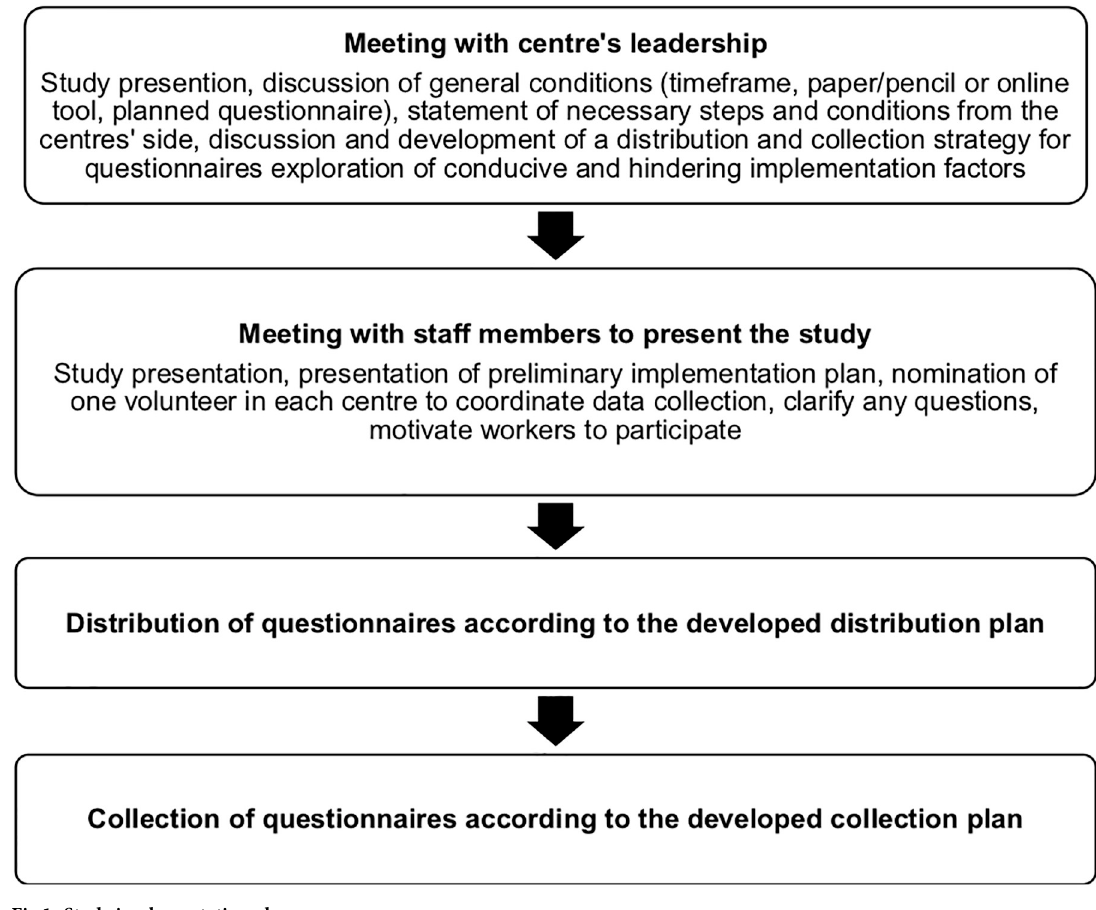
Fig 1. Study implementation